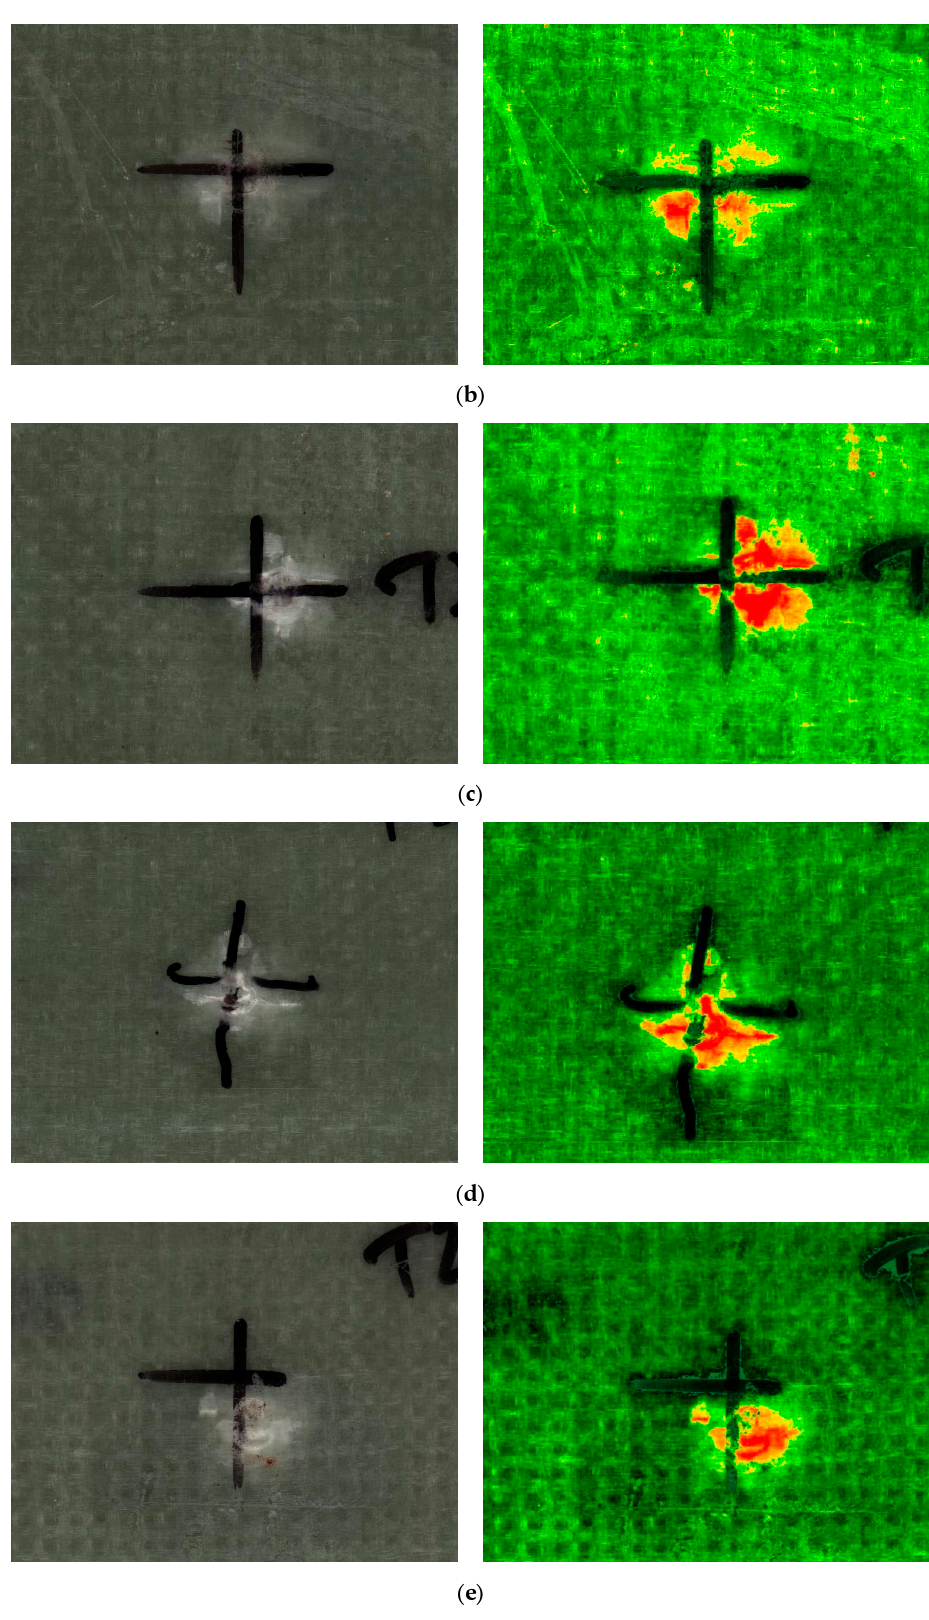
Figure 5. Induced damage due to low-velocity impact in ( a ) Pristine composite; ( b ) 0.25 wt% nanosilica- reinforced composite; ( c ) 0.5 wt% nanosilica-reinforced composite; ( d ) 0.75 wt% nanosilica-reinforced composite; ( e ) 1 wt% nanosilica-reinforced